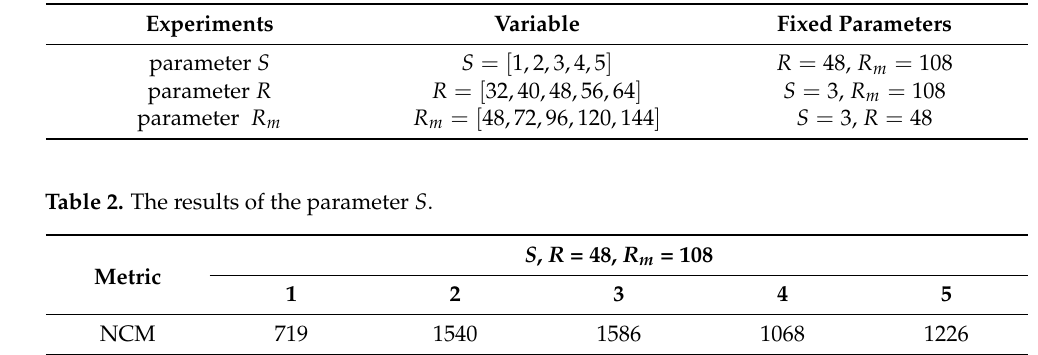
Table 1. Details of parameter settings.